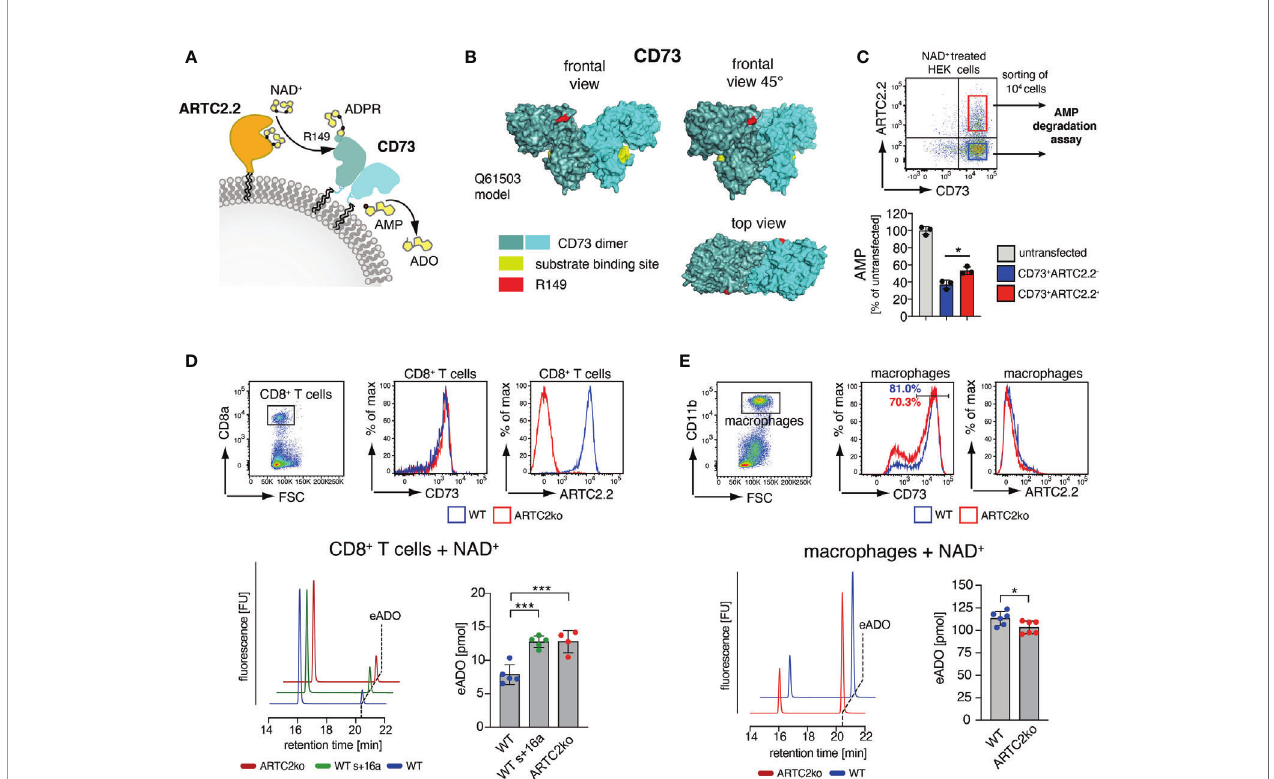
FIGURE 3 | ARTC2.2-dependent regulation of CD73 enzymatic activity. (A) CD73 can degrade adenosine monophosphate (AMP) to adenosine ADO. ARTC2.2 ADP-ribosylates CD73 at R149, potentially interfering with enzymatic activity. (B) The structure model Q61503 of a mouse CD73 dimer is shown in cyan. ADP- ribosylation site R149 (red) and substrate binding site (yellow) are indicated. (C) ARTC2.2 + CD73 + and ARTC2.2 – CD73 + HEK cells (n = 3) were incubated with NAD + , FACS sorted and compared towards their capacity to degrade AMP in the AMPGlo assay. (D) Spleen CD8 + T cells from B6 WT, B6 WT treated with ARTC2.2- blocking nanobody s+16a, and from ARTC2ko mice were analyzed towards CD73 and ARCT2.2 expression. After NAD + treatment, FACS sorted cells (n = 4-5 technical replicates) were further subjected to an HPLC-based assay to measure their capacity to generate etheno-ADO (eADO) from etheno-AMP (eAMP). (E) Peritoneal macrophages from B6 WT and ARTC2ko mice were analyzed towards CD73 and ARCT2.2 expression. After NAD + treatment, FACS sorted cells (n = 6 technical replicates) were analyzed for their capacity to generate eADO. Statistical comparison of the two groups was performed by using the Student ’ s t test, comparison of more than two groups was performed by using oneway ANOVA analyses with Dunnett ’ s multiple comparisons (p < 0.05 = */p < 0.001 = ***). Data represent results from two (C, E) or three (D) independent